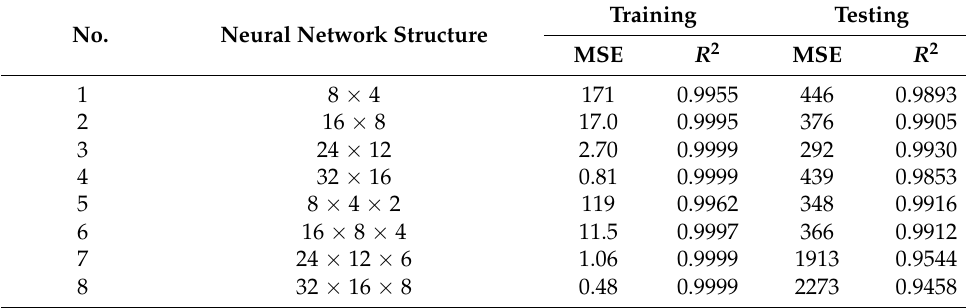
Table 2. Various structures to optimize the ANN.